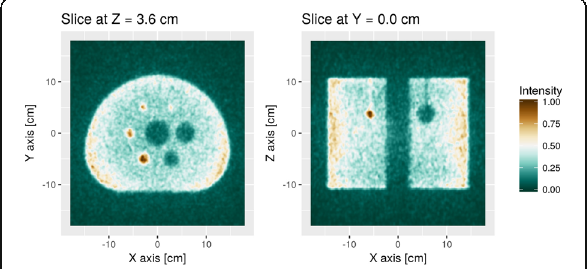
Fig. 1 (abstract A6). Transverse (left) and coronal (right) cross-sections of the reconstructed IEC phantom, simulated for the ideal J-PET scanner with SiPM+WLS readout, using multivariate